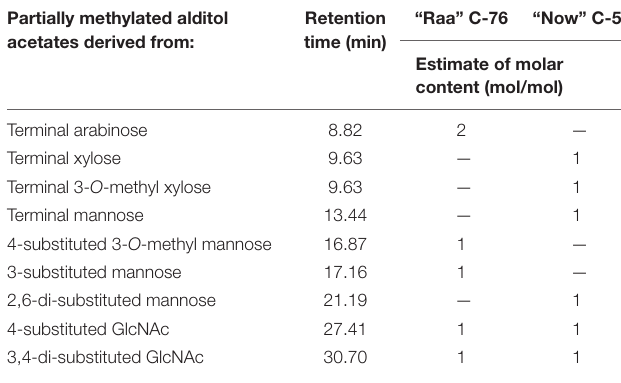
TABLE 2 | Results of linkage analysis via permethylation and GC-MS analysis of partially methylated alditol acetates of the isolated major peaks (os2221) of two microalgae